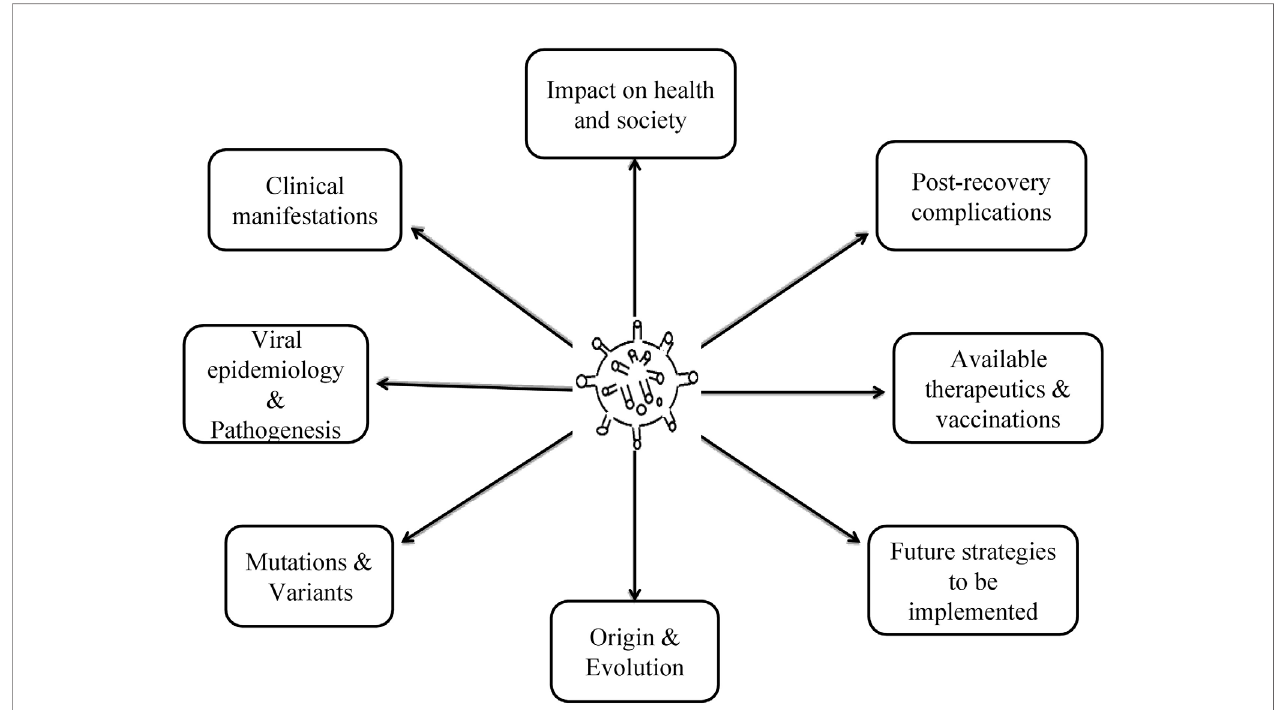
FIGURE 2 | Systematic overview of the complete